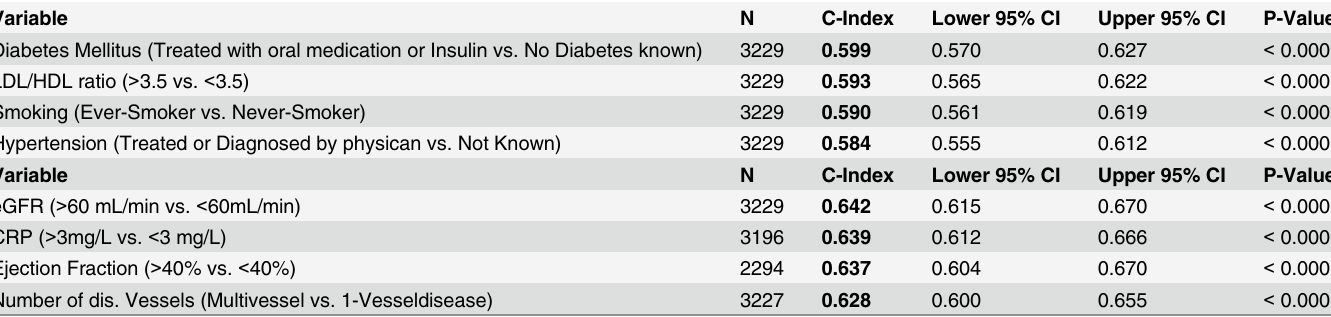
Table 4. Comparison of the C-Index regarding cardiovascular events vs. no events during follow-up in the overall cohort. Overall Cohort (N = 3229). Variable N Lower 95% CI Upper 95% CI Diabetes Mellitus (Treated with oral medication or Insulin vs. No Diabetes known) LDL/HDL ratio ( > 3.5 vs. < 3.5)